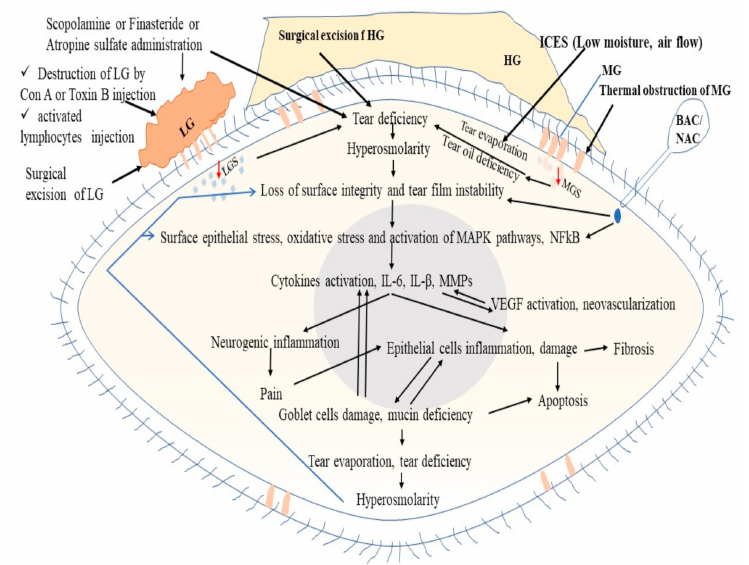
Figure 3. Mechanisms of various experimental methods for induction of dry eye disease. LG, lacrimal gland; LGS, lacrimal gland secretion; HG, Harderian gland; MBG, Meibomian gland; ICES, Intelligently controlled environmental system; BAC, Benzalkonium chloride; NAC, N-acetylcysteine; MAPK, Mitogen-activated protein kinase; NFkB, Nuclear factor kappa B; IL-6, Interleukin 6; IL-1 β , Interleukin-1beta; MMPs, Matrix metalloproteinases; VEGF, Vascular endothelial growth